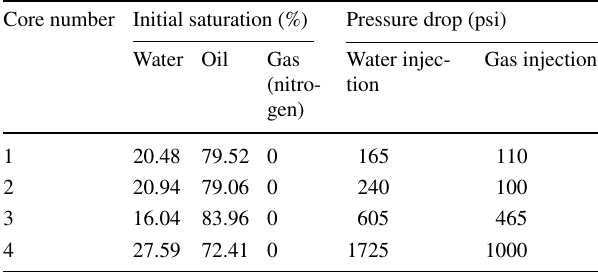
Fig. 1 Schematic of the saturation state in the core for the unsteady- state water-flooding test Table 3 Initial and boundary conditions used in the core-flood tests (water-flooding and gas